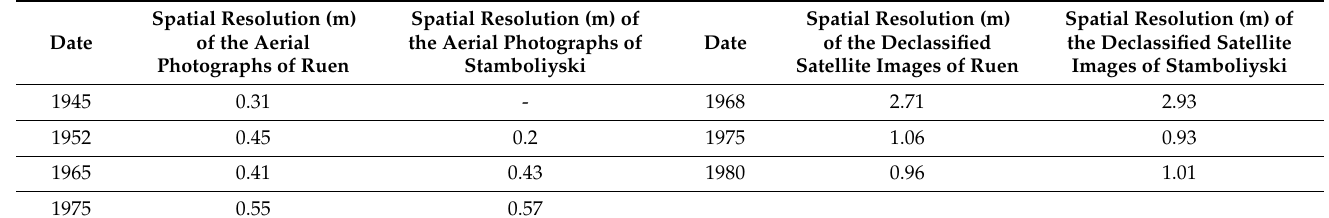
Table 4. Spatial resolutions of the Ruen and Stamboliyski geospatial dataset.